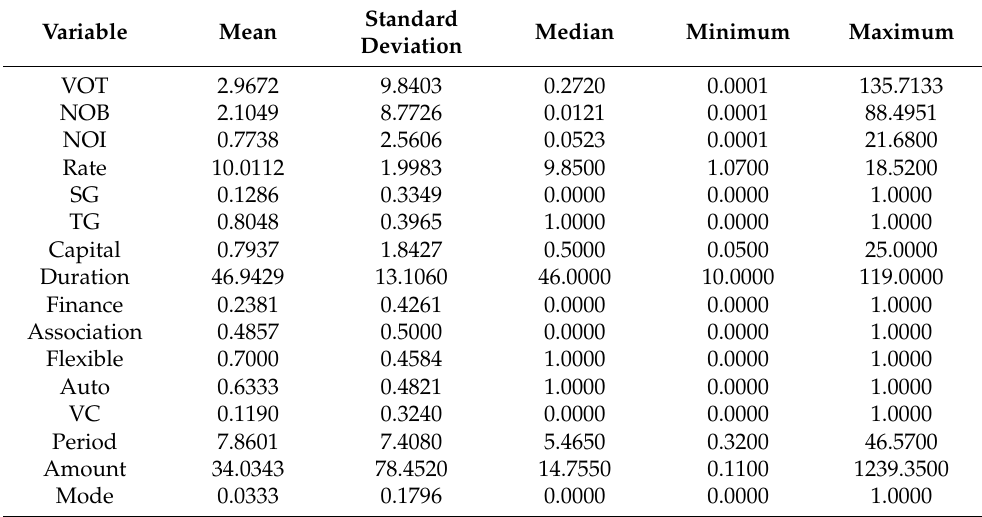
Table 6. Descriptive statistics of the variables.